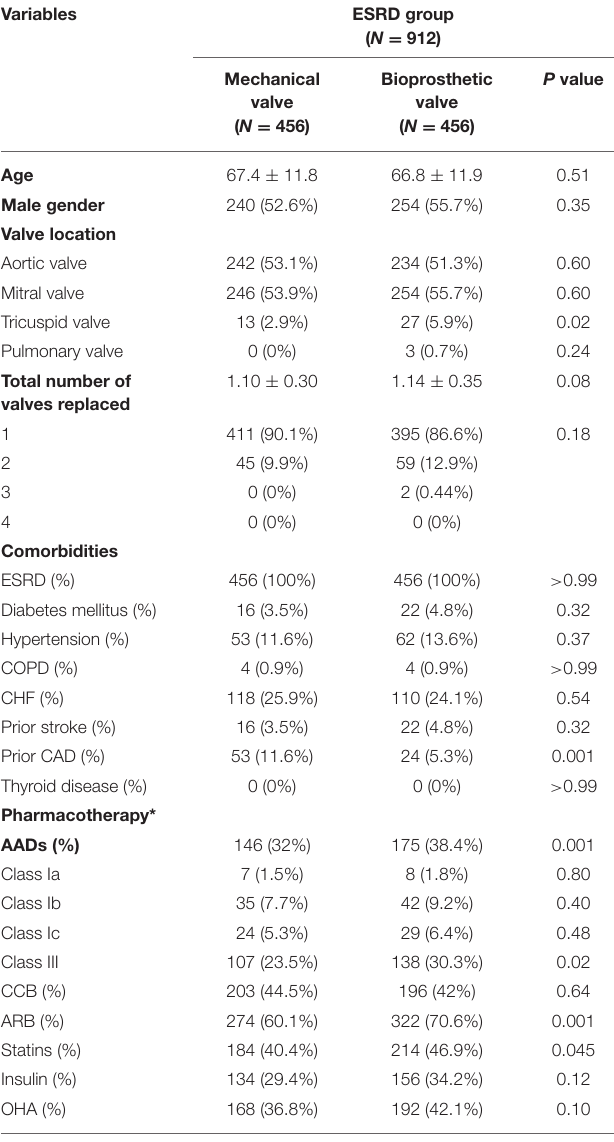
TABLE 1 | Baseline characteristics of ESRD cohorts after propensity-score matching.